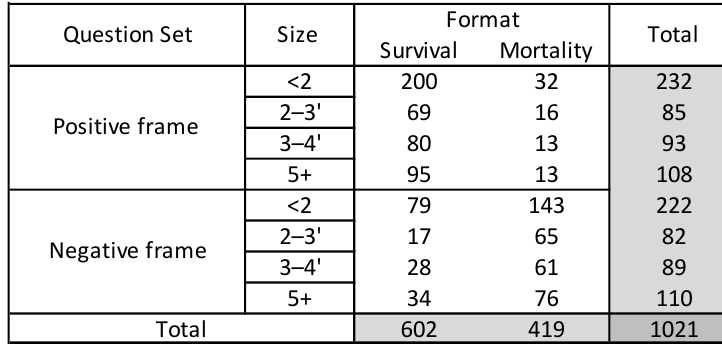
Figure 10. Respondent total by household size.